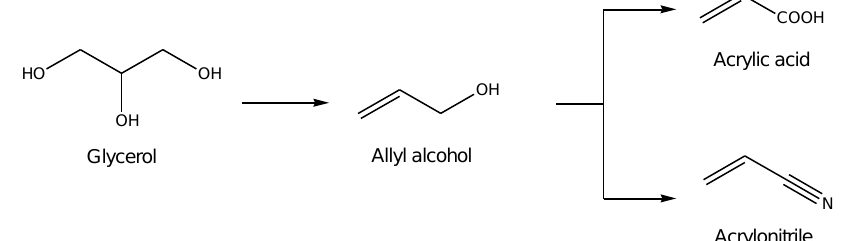
Figure 10. Production of important intermediates of the chemical industry using allyl alcohol from glycerol as an intermediate.